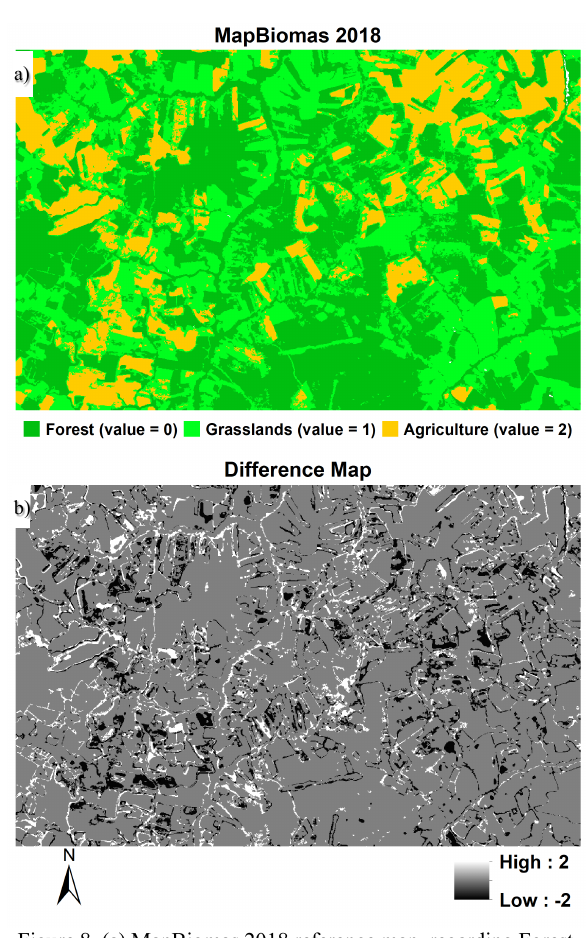
Figure 8. (a) MapBiomas 2018 reference map, regarding Forest, Grasslands and Agriculture classes. (b) Product of a difference operation between our VV+VH classification map and the MapBiomas reference